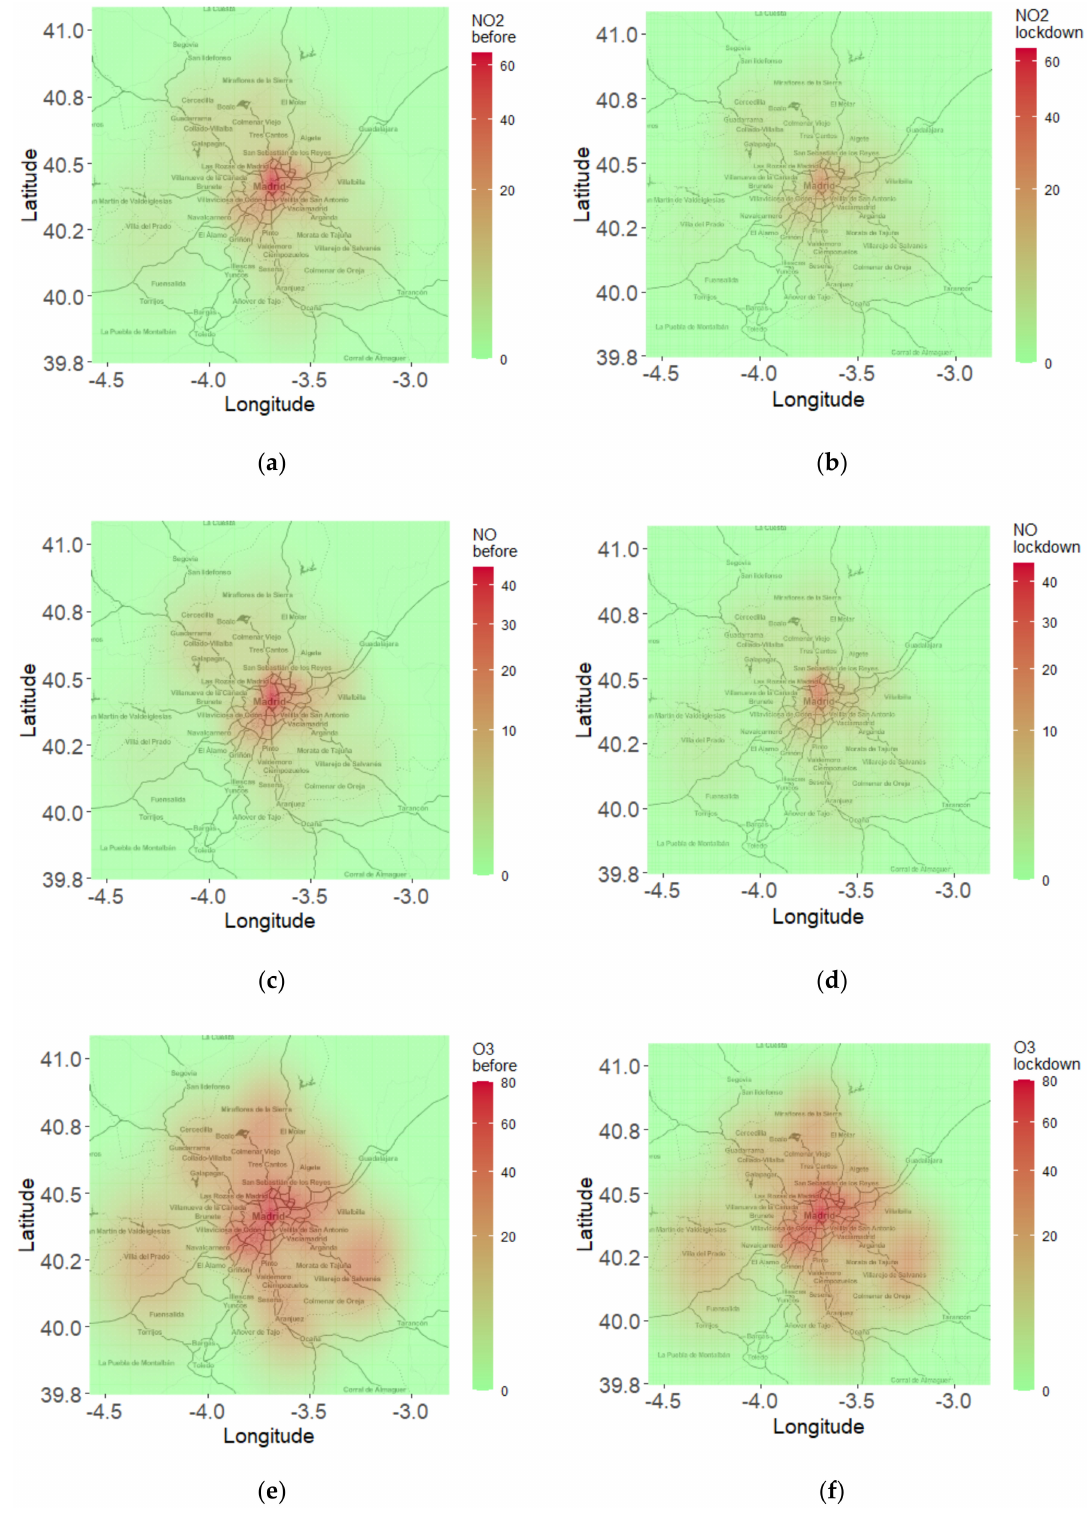
Figure 2. Daily average pollution levels before (left figure) and during the lockdown period (right figure). ( a , b ) NO, ( c , d ) NO 2 , ( e , f ) O 3